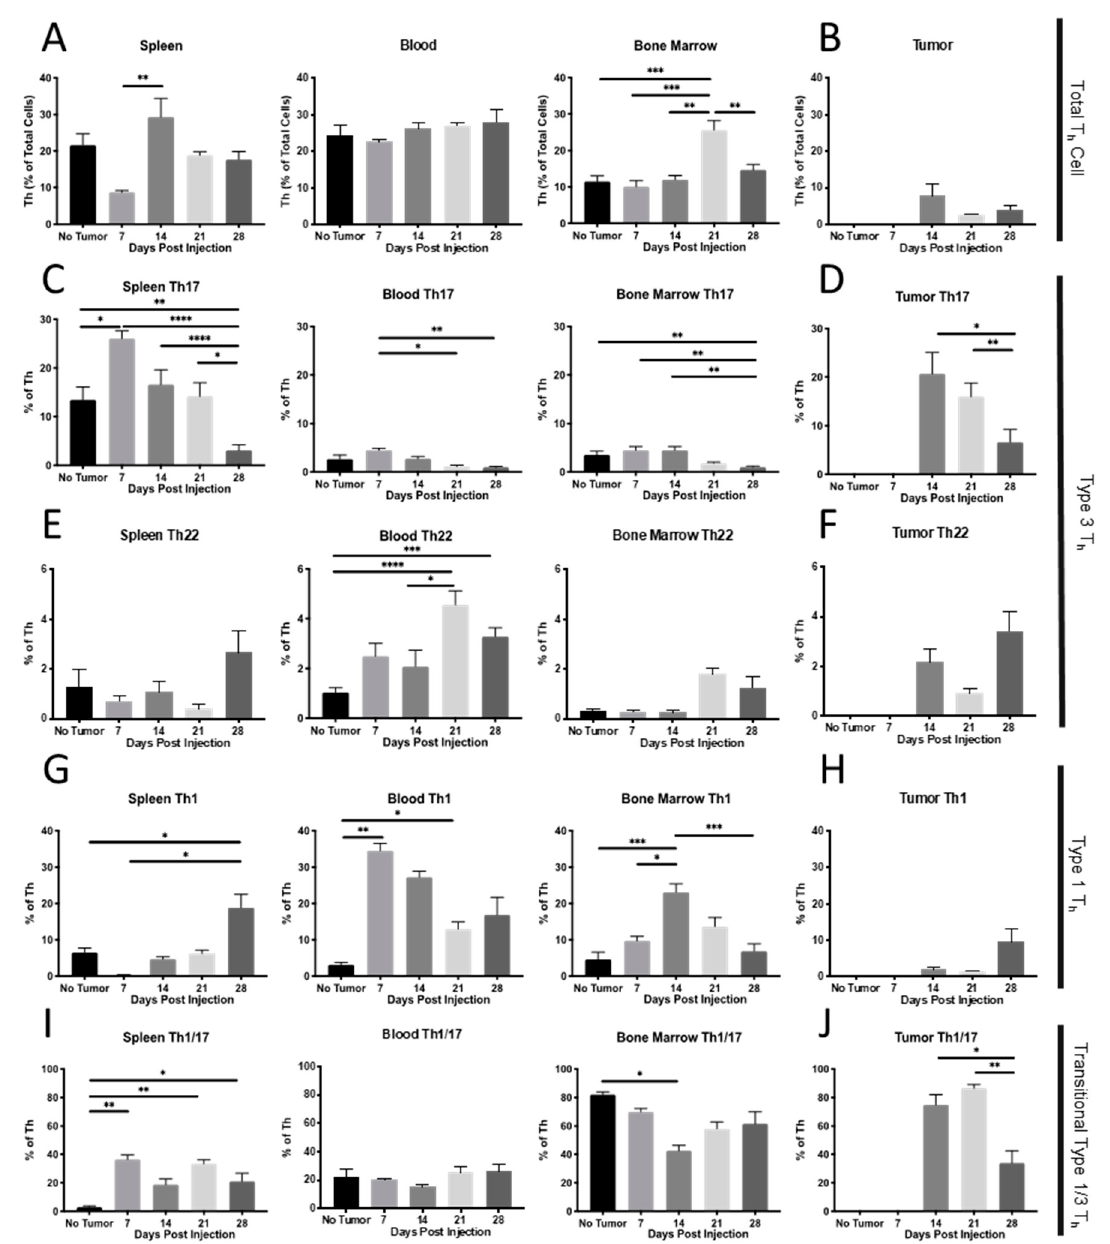
Figure 3. T h populations over time in 4T1-WT mammary tumor bearing mice. Flow cytometric measurement of total T h , T h 17, T h 22, T h 1, and T h 1/17 in peripheral tissues ( A , C , E , G , I ) or tumors ( B , D , F , H , J ) at the indicated times. Data are presented as mean ± SEM; n = 4–11 mice per time point. * p < 0.05, ** p < 0.01, *** p < 0.001, and **** p < 0.0001.